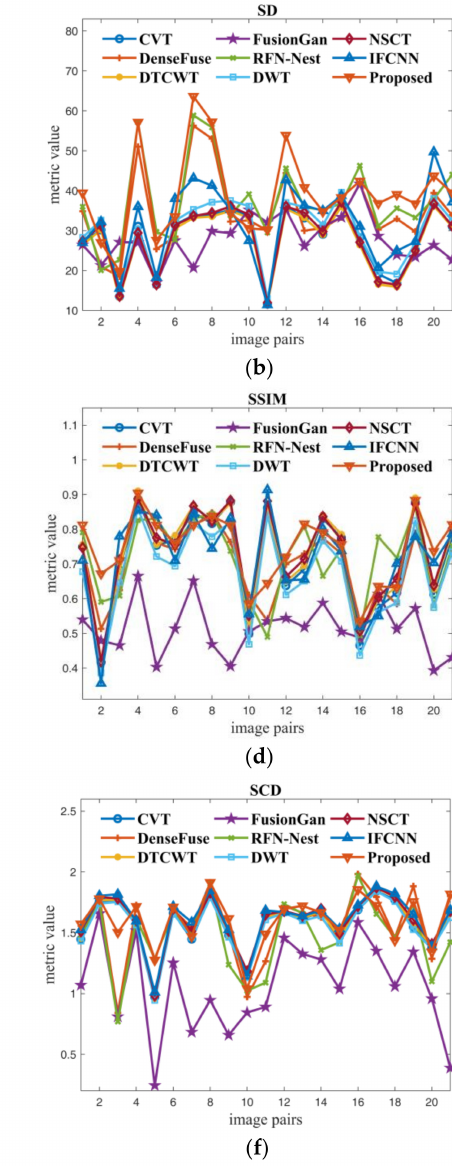
Figure 7. Quantitative comparison of the proposed method against eight existing fusion methods by using six metrics on 21 pairs of images from TNO dataset. ( a – f ) are the comparison results of the nine methods on EN, SD, RMSE, SSIM, MI and SCD